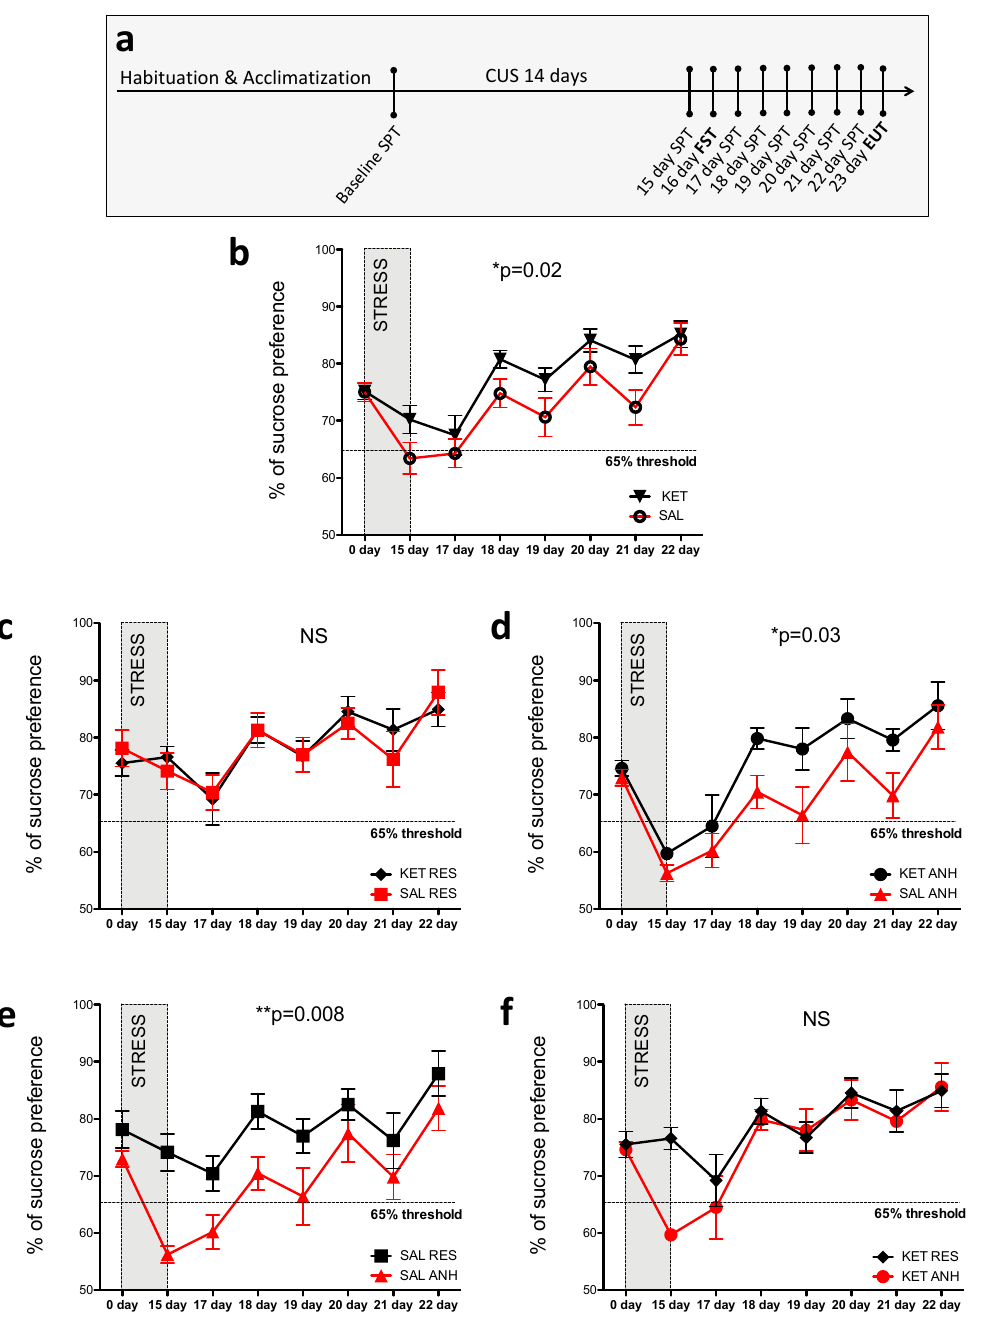
Figure 1. Ketamine treatment before the modified CUS procedure altered the sucrose preference profile in C57BL6J mice. ( a ) Schematic representation of the experimental procedure. After the acclimatization and habituation period, the mice were subjected to the 14-day CUS procedure, followed by 8 days of the daily sucrose preference test, with the exception of day 16 (i.e., 2 days after the end of CUS when the force swim test [FST] was performed). ( b–f ) Sucrose preference profiles in all of the mice ( b ), resilient mice ( c ), anhedonic mice ( d ), saline-treated mice ( e ), and ketamine-treated mice ( f ). The data are expressed as mean ± SEM. * p < 0.05, ** p < 0.01 (two-way ANOVA). Numbers of animals after CUS exposure: n = 16 ketamine-treated mice (six anhedonic mice and ten resilient mice), n = 15 saline-treated mice (nine anhedonic mice and six resilient mice).